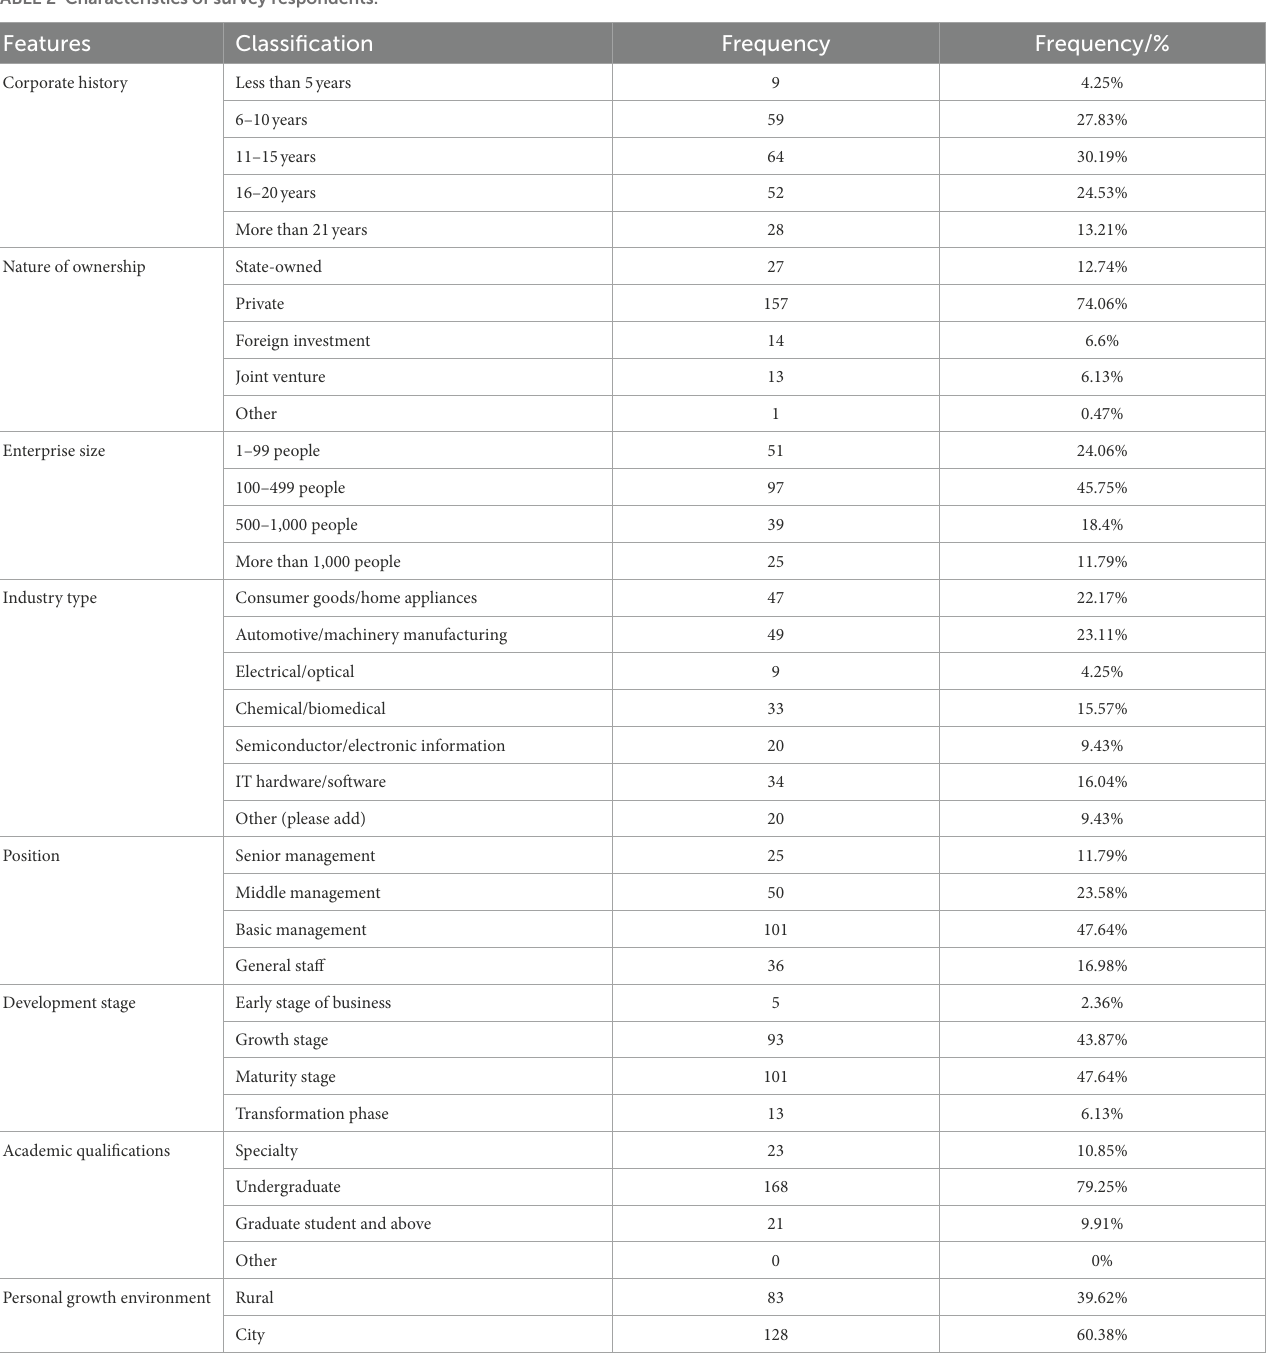
TABLE 2 Characteristics of survey respondents.